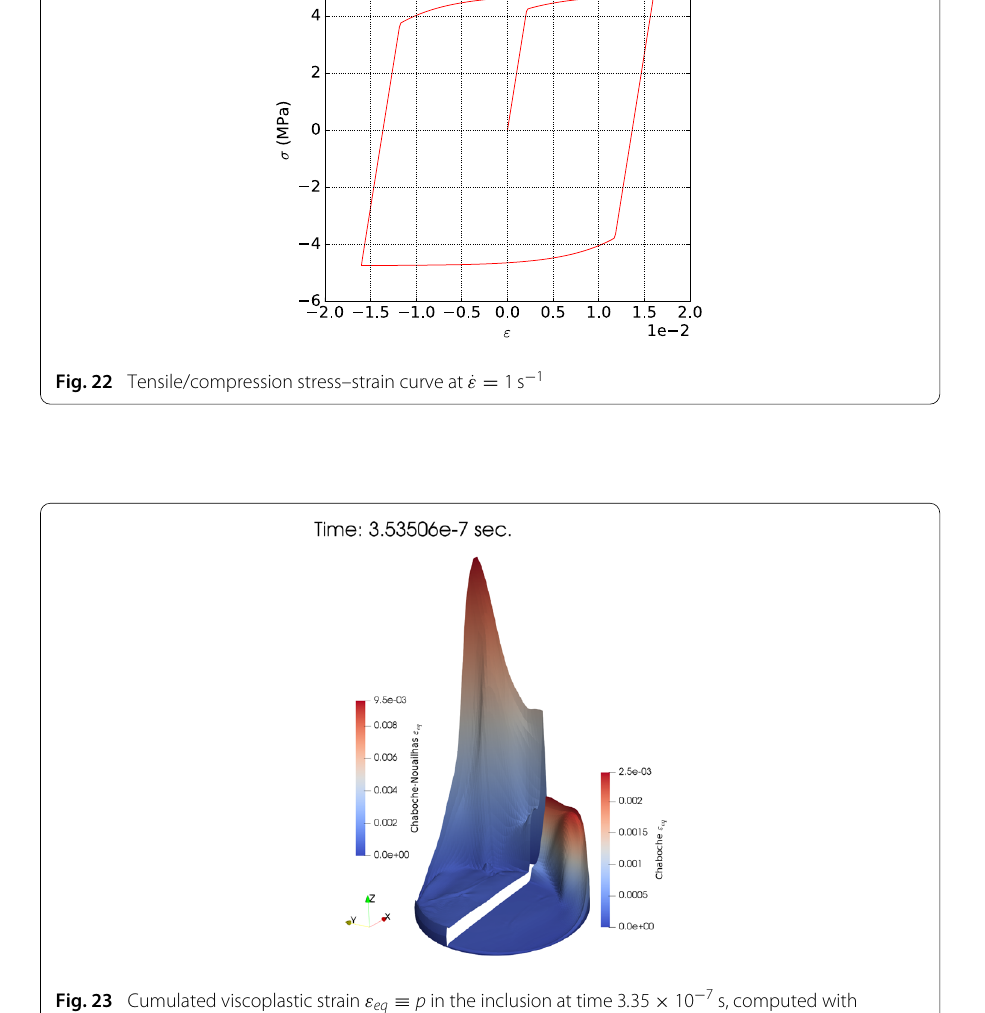
of the interface with the matrix (see Fig. 23). This is provided by the circular geometry of the inclusion that defines a concentrating profile as the compression wave travels right- ward. In Figs. 24 and 25, isovalues of the effective viscoplastic strain rate are shown at two successive instants, as the compression slot passes. The observed profiles appear quite different in terms of the chosen viscoplastic constitutive model. In particular, the satu- ration of the overstress predicted by expression (60) combined with the particular rear geometry of the interface inclusion/matrix yield an effective strain rate that reaches very high numerical values on a narrow band. This small example illustrates the importance of the chosen viscoplastic constitutive model on the propagated viscoplastic strains in a dynamic